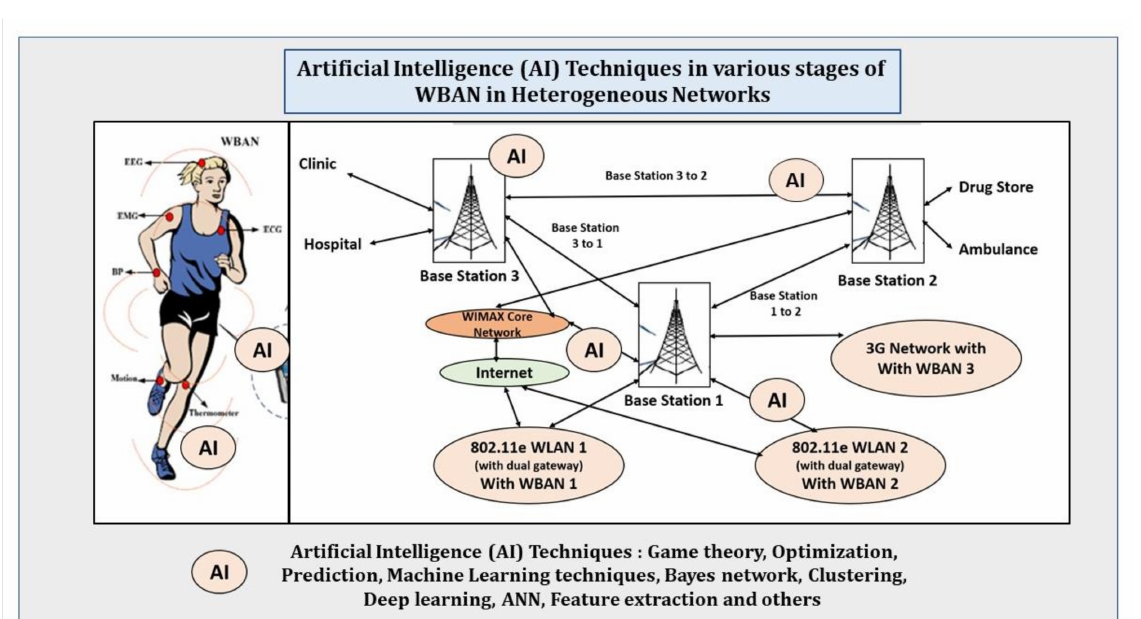
Figure 11. AI techniques in various stages of WBAN in the heterogeneous